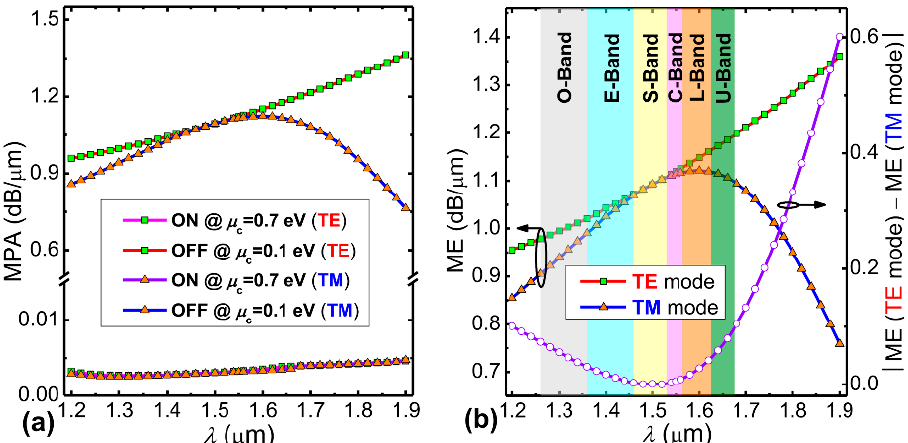
Figure 4. ( a ) The wavelength-dependence of MPA at both the “ON” and “OFF” states for TE and TM modes. ( b ) The corresponding wavelength-dependence of MEs and their absolute difference of the hybrid graphene-silicon waveguide for both polarizations.